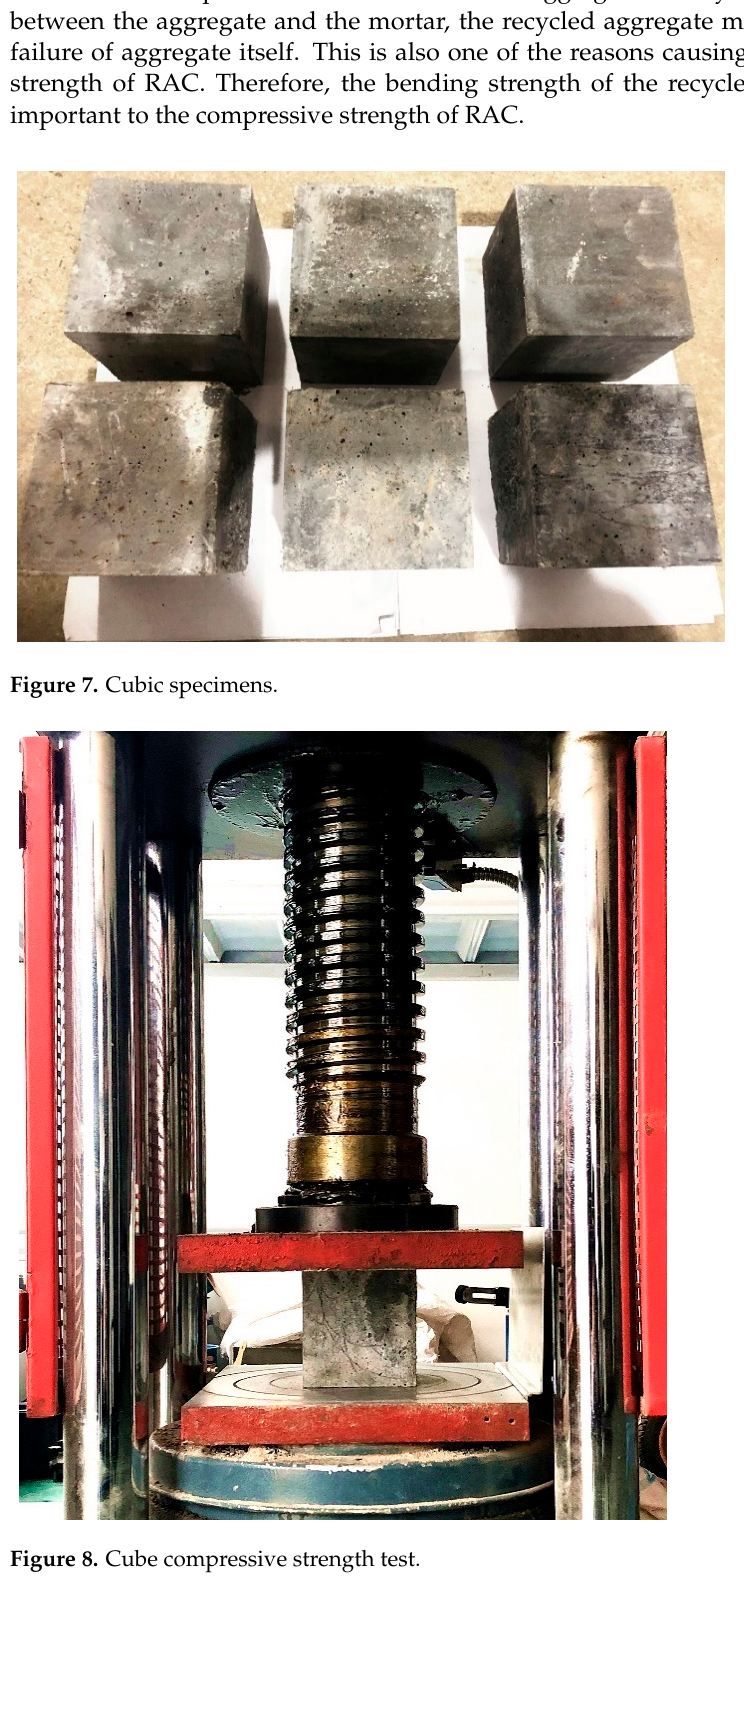
Figure 9. Specimen failure crack and failure interface morphology. 2.4. Experimental Results Throughout the experiment, a data set containing 88 different mixing proportions was obtained, which was used to train the ANN model. Table 4 shows all the experimental mixing proportion data. Table 4. Experimental mixing proportion data. Division